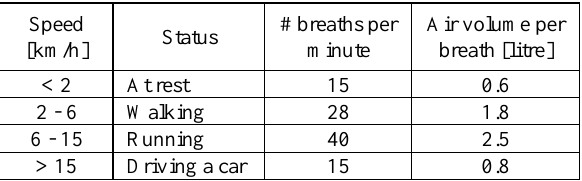
Table 1. The breathing model adopted so far